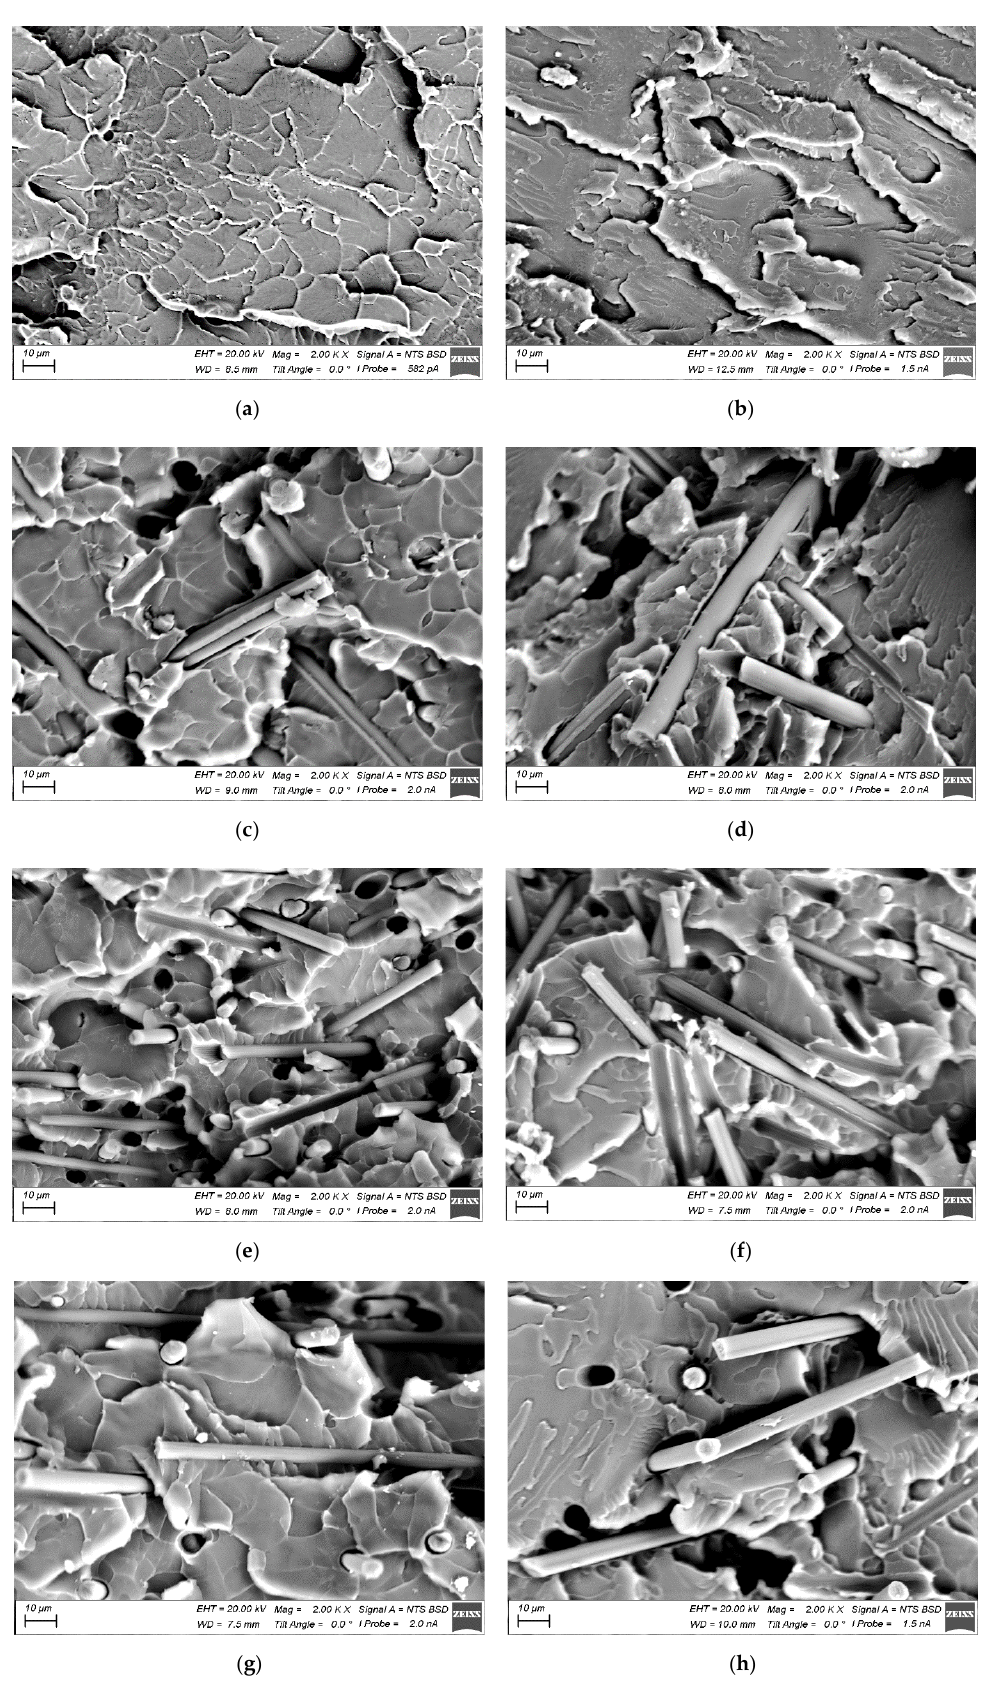
Figure 2. SEM micrographs of the structure of the PI- and PEI-based composites: PI/CF100 ( a ); PEI/CF100 ( b ); PI/CF200 ( c ); PEI/CF200 ( d ); PI/CF2000 ( e ); PI/CF2000 ( f ). The specimen designations are presented in Table 2, below. ( b ); PI/CF100 ( c ); PEI/CF100 ( d ); PI/CF200 ( e ); PEI/CF200 ( f ); PI/CF2000 ( g ); PI/CF2000 ( h